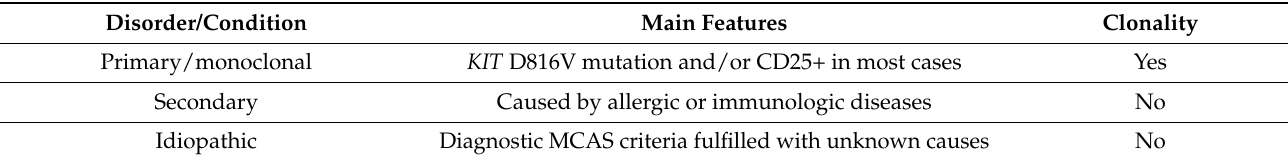
Table 1. Mast cell activation